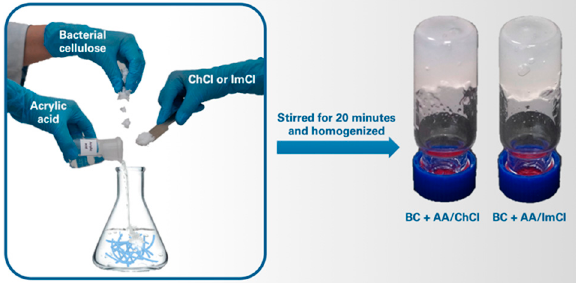
Figure 2. Preparation scheme and images of BC ion gels in AA/ChCl and AA/ImCl mixtures.